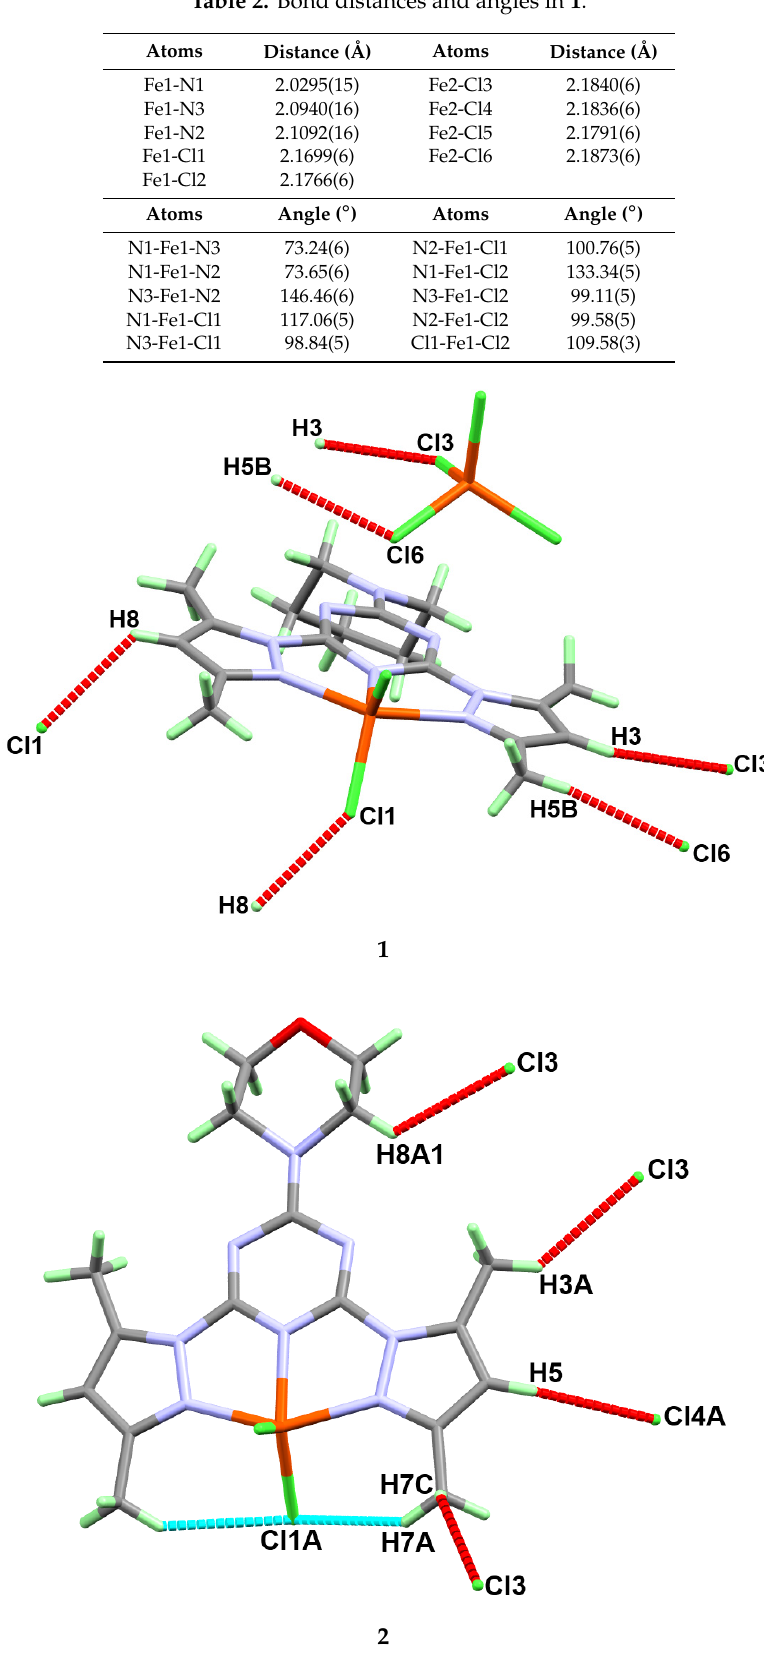
Figure 3. The hydrogen bond contacts in complexes 1 (upper) and 2 (lower).